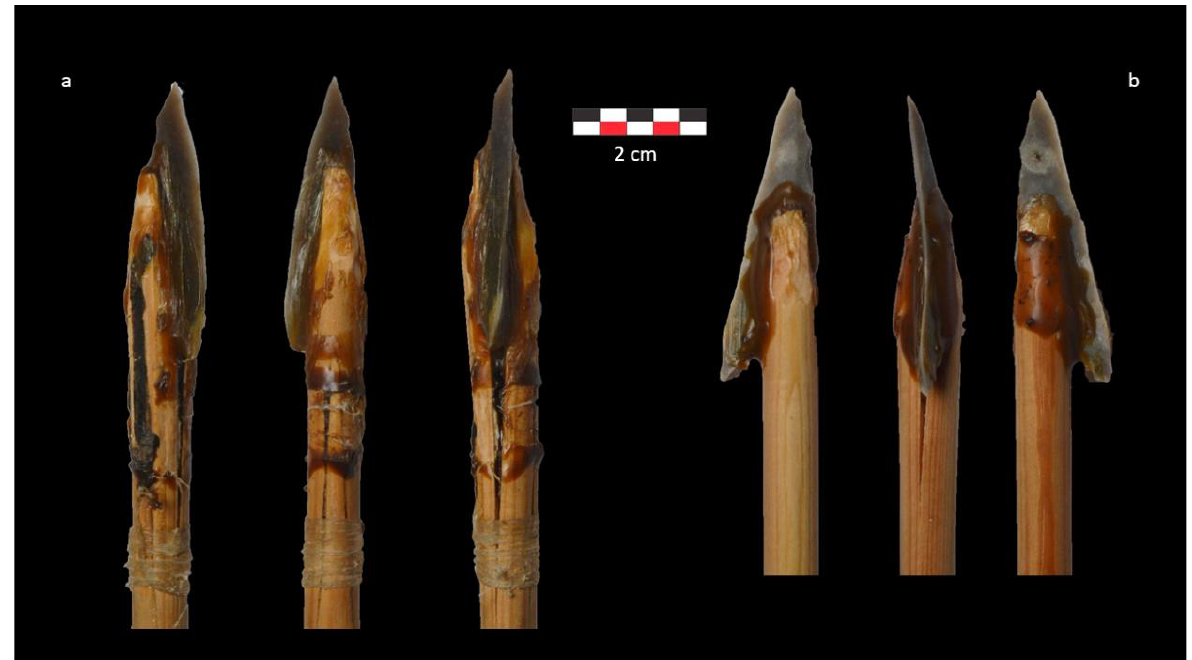
Figure 16. Boxplot comparing the morphological variations between the curved backed points from Lommel-Maatheide identified as projectiles and their experimental reproductions.